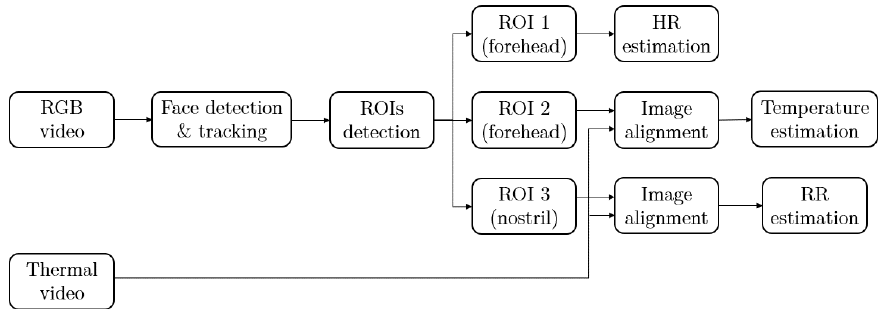
Figure 2. The workflow of vital signs estimation using RGB and thermal